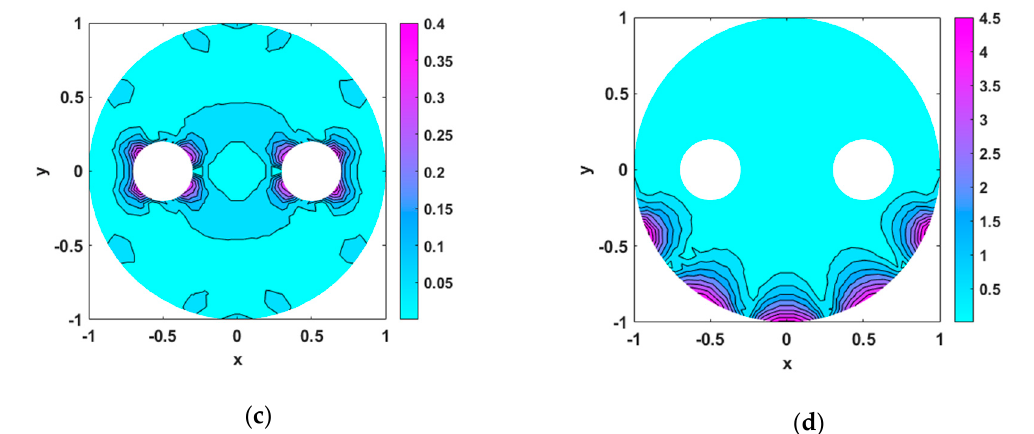
Figure 12. Contour plots of absolute errors (%): ( a ) half unknown inner boundary; ( b ) two half unknown inner boundaries; ( c ) unknown inner boundaries; ( d ) half unknown outer boundary.